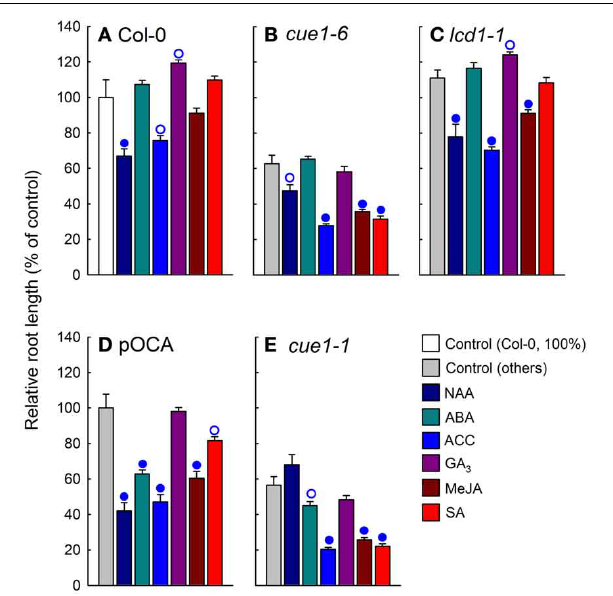
FIGURE 9 | Effect of phytohormone feeding on root growth of cue1 and lcd1 compared to wild-type or control plants. Individual phytohormones (10 μ M each) were fed for seven days to Col-0 (A) , cue1-6 (B) , lcd1-1 (C) , pOCA (D) , and cue1-1 (E) . The relative root lengths are shown compared to the unfed controls (white bars for Col-0 or light gray bars for the other lines). The circles indicate significant differences in root lengths of fed compared to unfed plants with P -values < 0.01 (closed circles) and < 0.05 (open circles). The data represent the mean ± SE of the mean of n = 9 measurements.